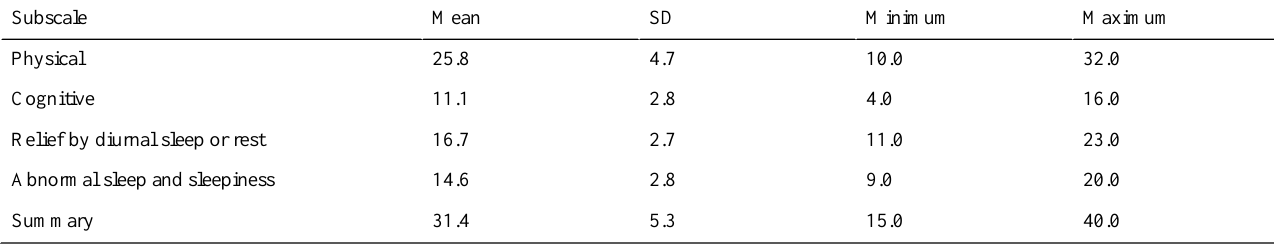
Table 2. Descriptive statistics of the Neurological Fatigue Index (n=47).